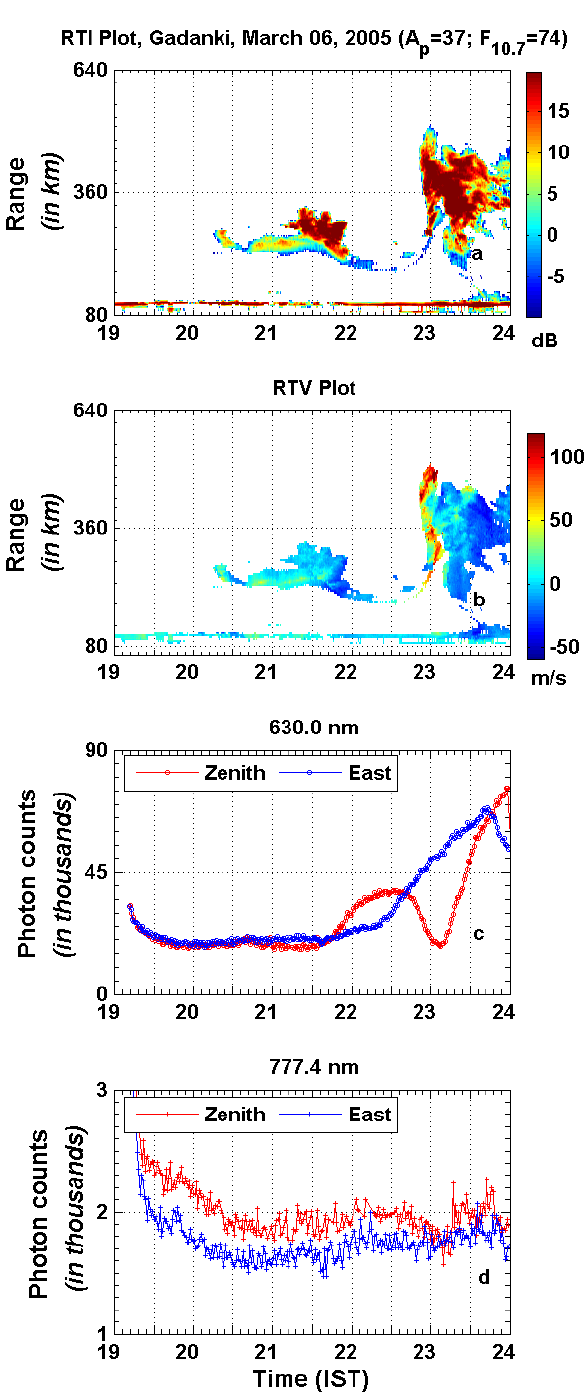
Fig. 10. Similar to Fig. 9 but for 6 March 2005 including the 777.4nm observations in the bottom panel. The observations reveal the plasma bubble